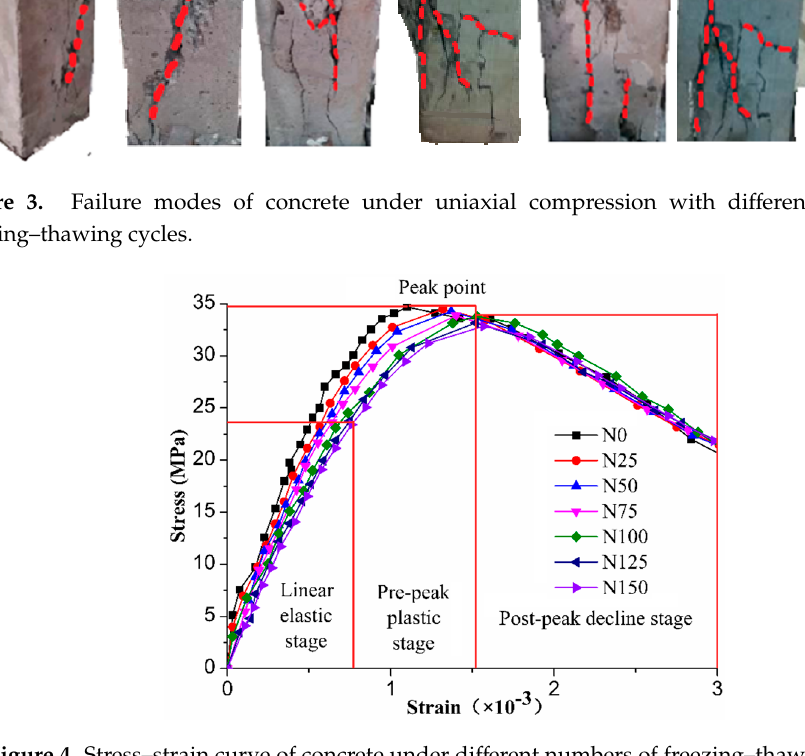
( a ) ( b ) Figure 5. ( a ) Peak stress and ( b ) peak strain of concrete under different numbers of freezing–thawing cycles. Figures 3 and 4 show that the severity of the uniaxial compression damage to concrete increased with the increase in the number of freezing–thawing cycles. When the concrete specimens without freezing–thawing were damaged, diagonal cracks mainly occurred. However, with the increase in freezing–thawing cycles, concrete became more brittle and the risk of bursting became less serious. With 25 freezing–thawing cycles, the diagonal main cracks deepened and large breaks in flakes or bulk along the direction of the main cracks occurred. The situation became more obvious with the increase in the number of freezing–thawing cycles. So when the specimen was damaged, many vertical main cracks usually occurred. With increasing freezing–thawing cycles, the micro-cracks inside the concrete gradually increased [5], which further deformed the specimen transversely under compression, resulting in the vertical cracking of concrete for its transverse tension. With increasing the compressive load, the change law of stress–strain curve of freezing–thawing-damaged concrete